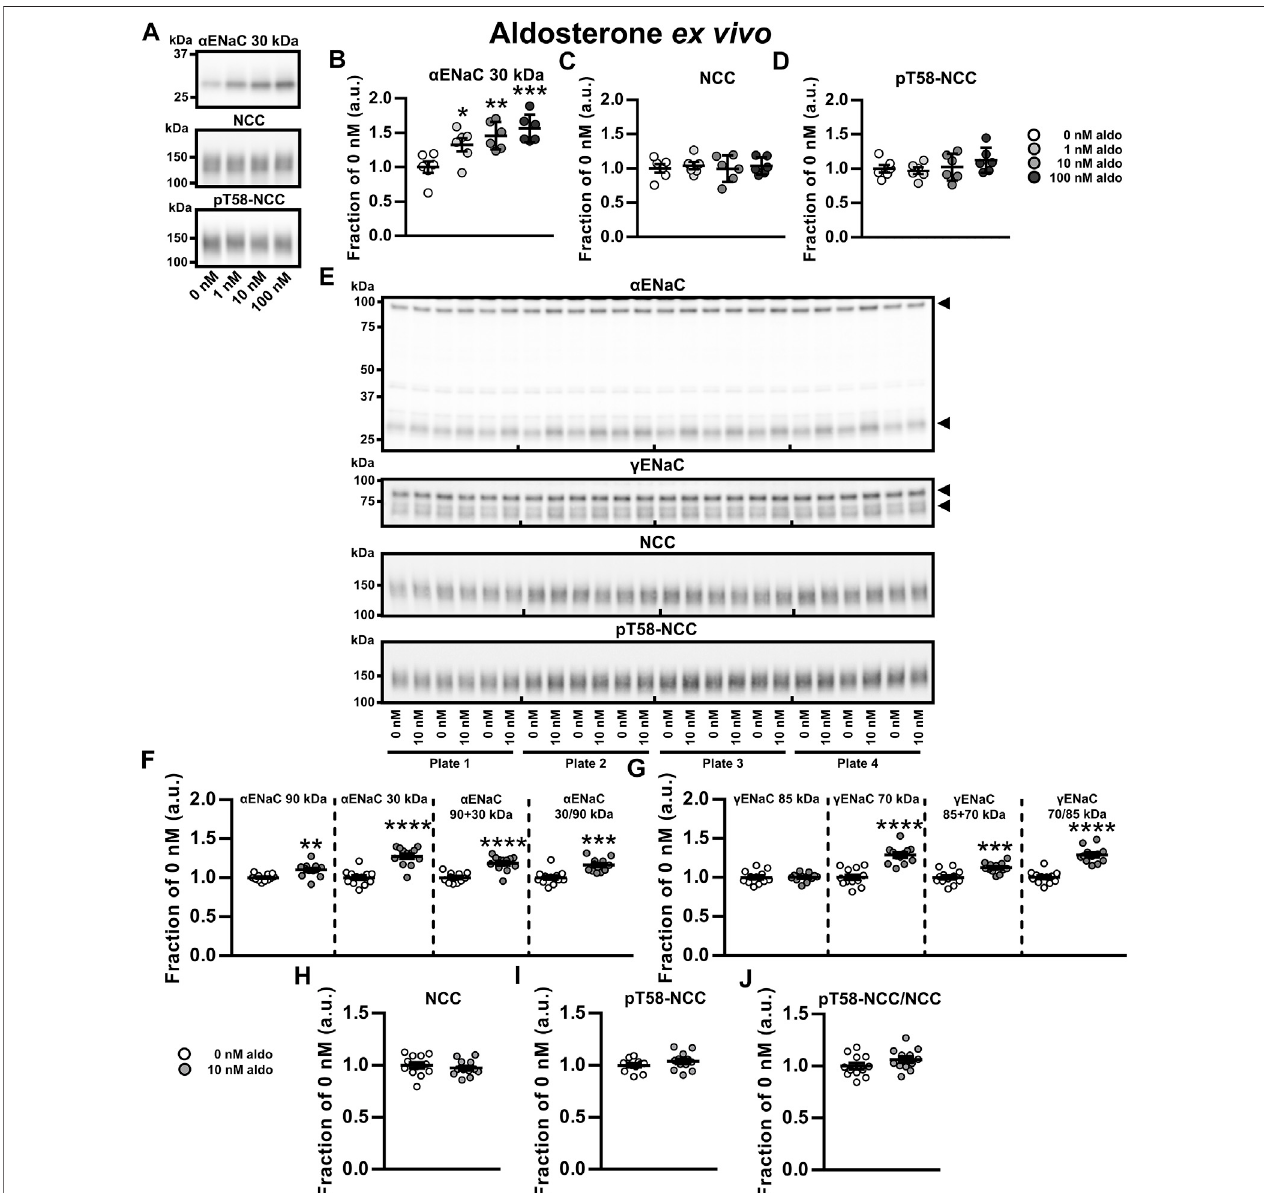
FIGURE 3 | Aldosterone increased ENaC but did not affect abundance or phosphorylation of NCC ex vivo . (A – D) A dose-response ex vivo experiment on kidney tubule suspensions showed that exposure to physiologically relevant aldosterone (aldo) concentrations (1, 10 and 100 nM) for 21 h increased cleaved α ENaC (30 kDa) whereas no signi fi cant effect was found on NCC and pT58-NCC. (E,F) Exposure to 10 nM aldosterone increased non-cleaved α ENaC (90 kDa), cleaved α ENaC (30 kDa),total α ENaC(90+30 kDa)andtheratiobetweennon-cleavedandcleaved α ENaC(30/90 kDa). (E,G) Furthermore,10 nMaldosteroneincreasedcleaved γ ENaC(70 kDa),total γ ENaC(85+70 kDa)andtheratiobetweennon-cleavedandcleaved γ ENaC(70/85 kDa). (E,H – J) Nosigni fi canteffectwasfoundonNCC,pT58- NCCorthepT58-NCC/NCCratio.Arrowsinpanel E indicatecleavedandnon-cleavedformsof α ENaC(90and30 kDa)and γ ENaC(85and70 kDa).Dataarepresented as dot plots and mean ± SEM. Experiments were perform in 6-well plates and quanti fi ed values were normalized to 0 nM aldosterone within individual plates. n = 6 per group (A – D) or n = 12 per group (E – J). Statistical comparisons were performed using a one-way ANOVA followed by post-hoc testing with FDR-correction (A – D), Satterthwaite ’ s 2-tailed unequal variance t -test [panel (F) , α ENaC 90 kDa] or Student ’ s 2-tailed t -tests [all other comparison tests in panel (F – J) ]. * p < 0.05, ** p < 0.01, *** p < 0.001, **** p < 0.0001.